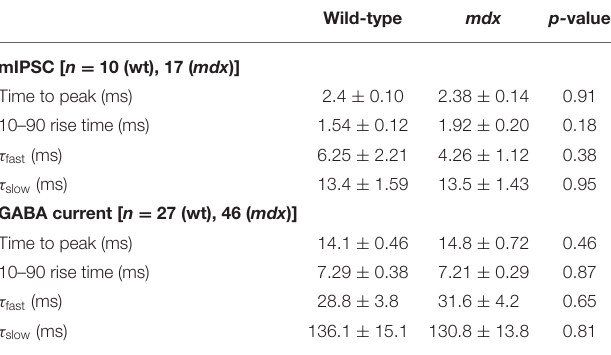
TABLE 1 | Kinetic properties of mIPSC and GABA-evoked currents.